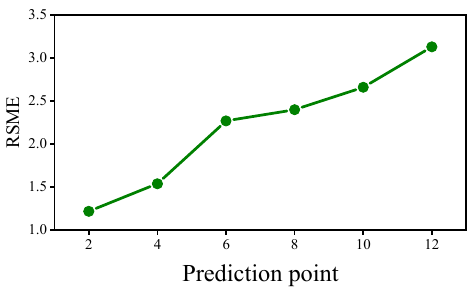
Figure 7. Prediction error for different number of prediction points.